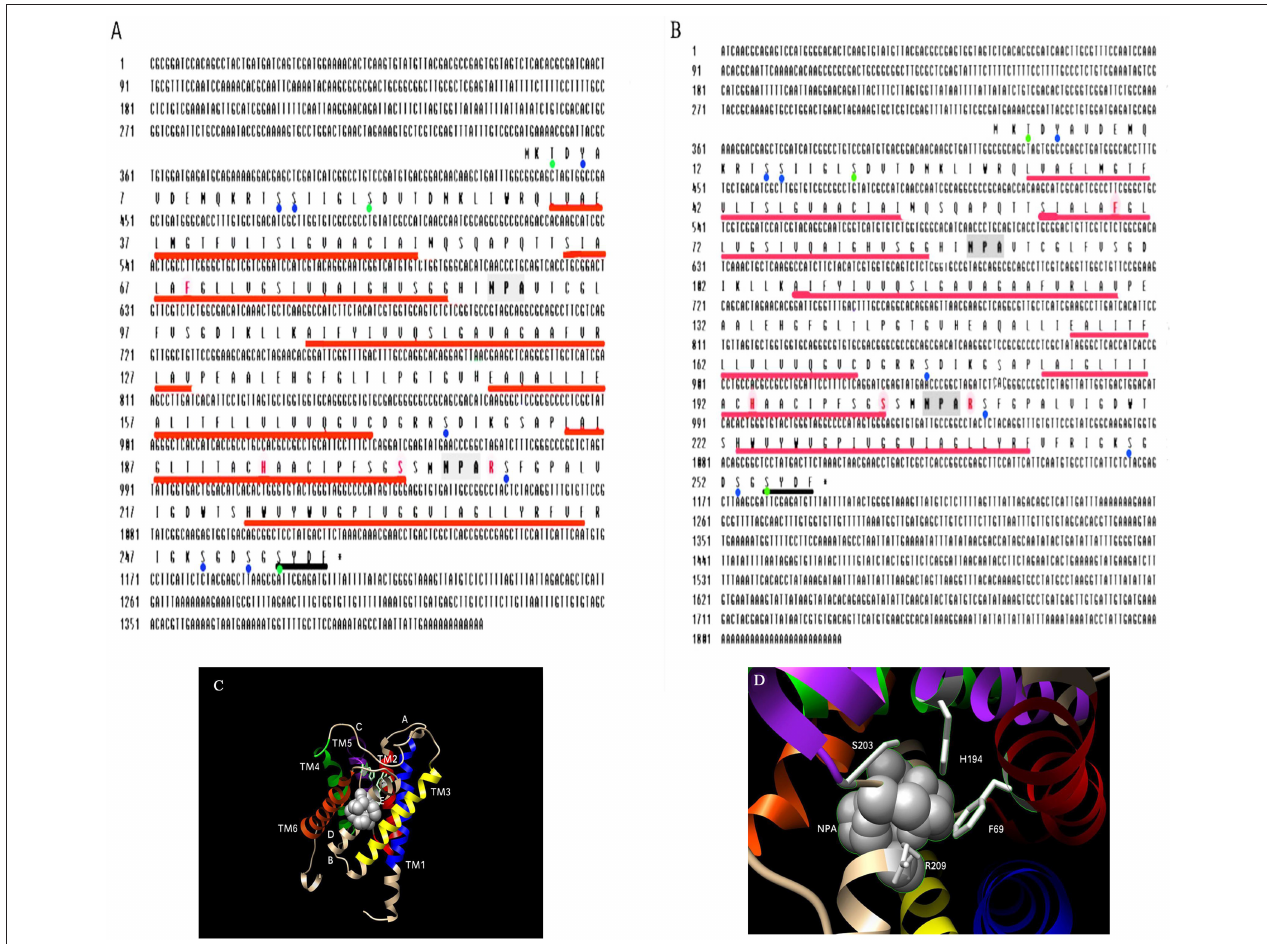
FIGURE 1 | Sequence analysis, predicted topology and structure of Cs Drip1. (A,B) Nucleotide and deduced amino acid sequence of Cs Drip1 variant A (JQ011314) and variant B (JQ011315). Six transmembrane domains (TMs) are also shown by the red underline and C-terminal “SYDF” sequence found in insect AQPs with dark underline. The NPA boxes are shown with gray highlight. Orange indicates amino acids residues constituting the ar/R constriction region. Blue dots and green dots, respectively are potential phosphorylation sites and protein kinase C-specific sites. (C) Homology modeling of the Cs Drip1 is compared with bovine aquaporin-1 (PDB ID: 1J4N) as template using Phyre2. Intracellular (B,D) and extracellular (A,C,E) loops and transmembrane helices are shown (TM1 in blue, TM2 in red, TM3 in yellow, TM4 in green, TM5 in purple, TM6 in orange). (D) The structure depicted is from the extracellular side of the membrane. The classical NPA motifs are shown in